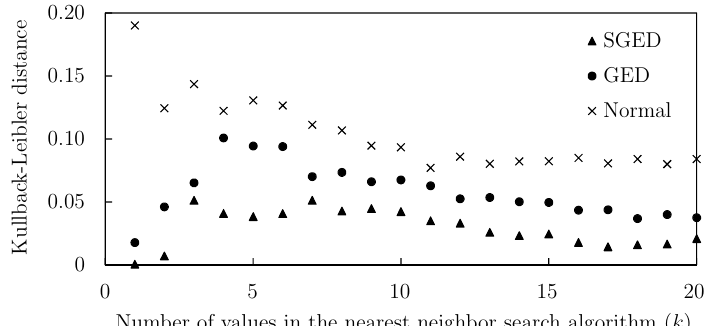
Figure 7. Illustration of the values of the Kullback–Leibler distance based on Table